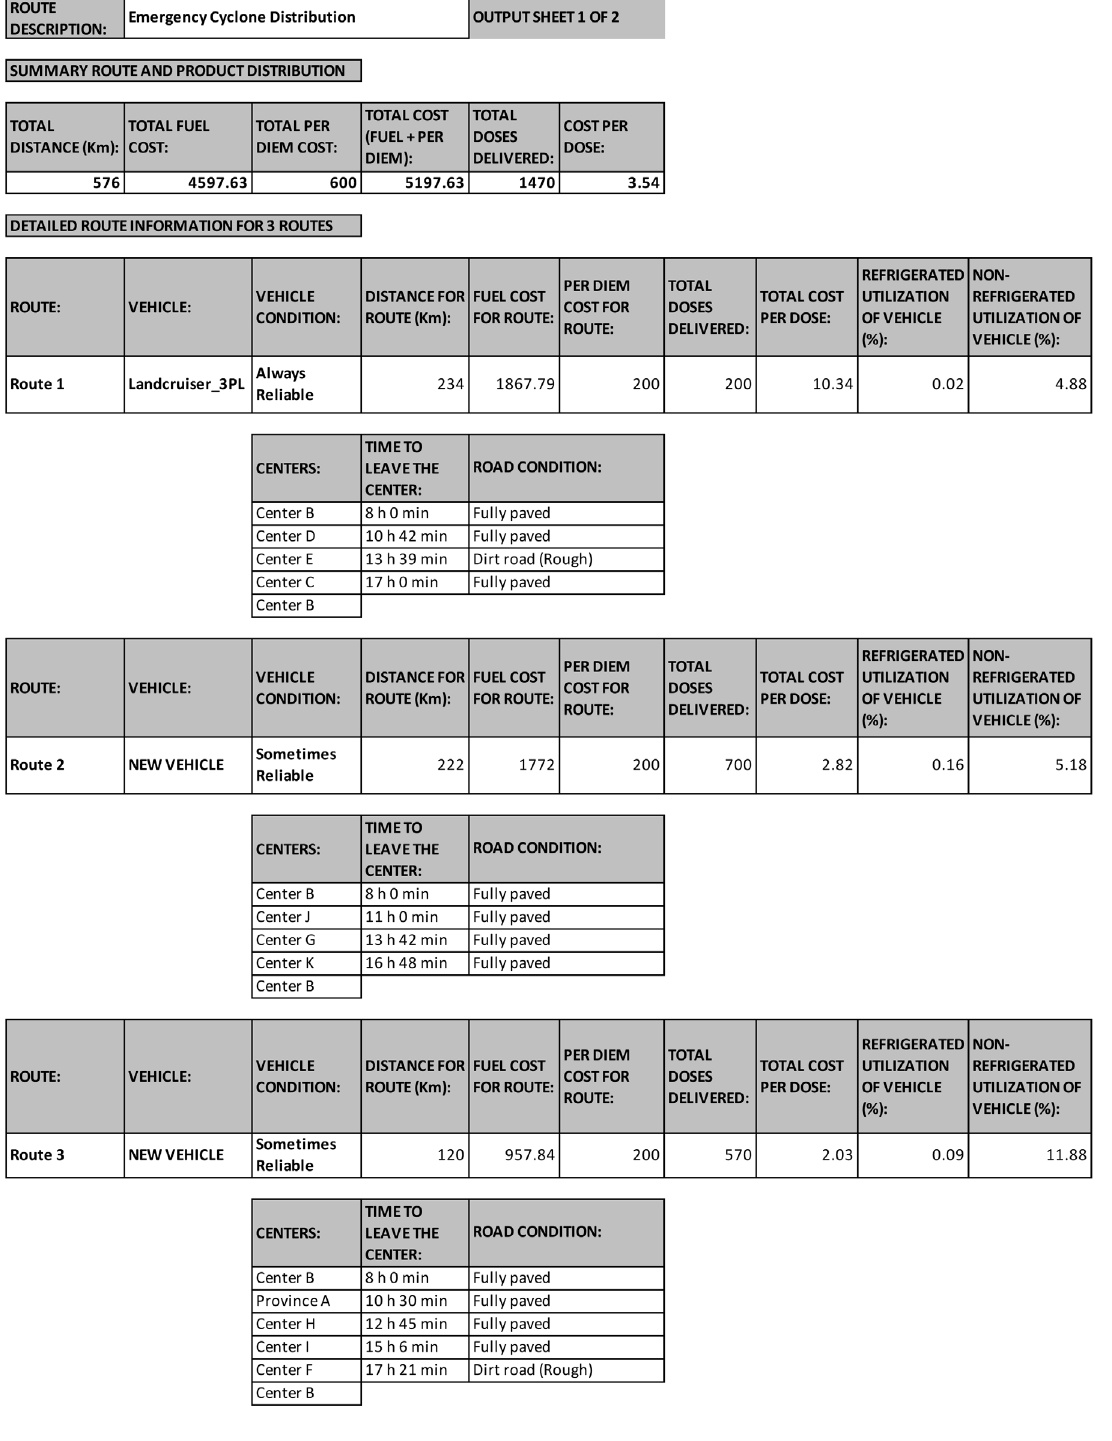
Software availability Route Optimization Tool (RoOT), with user guide and underly- ing data is available from: https://github.com/villagereach/RoOT